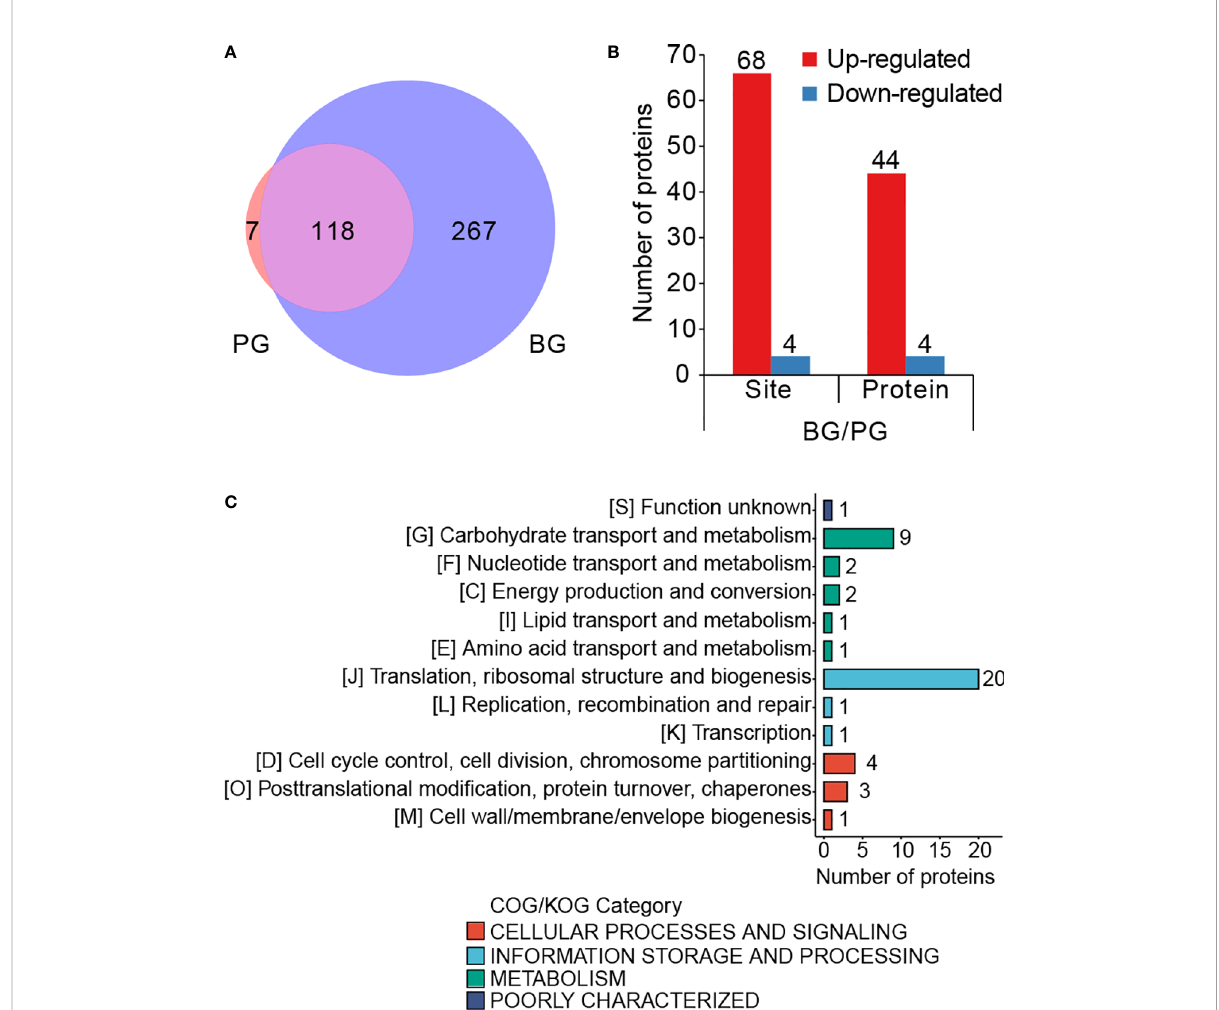
FIGURE 4 Lysine malonylome in bio fi lm is signi fi cantly different from that of planktonic growth. (A) Venn diagram showing the total number of PG-only (~1.79%), BG-only (~68.11%) and overlapping (~30.1%) modi fi ed sites ( fi ltered with a threshold value of modi fi cation fold change >1.5 or <1.5). (B) Bar graph for the number of differentially modi fi ed sites and the corresponding proteins. (C) COG-based classi fi cation of the differentially modi fi ed